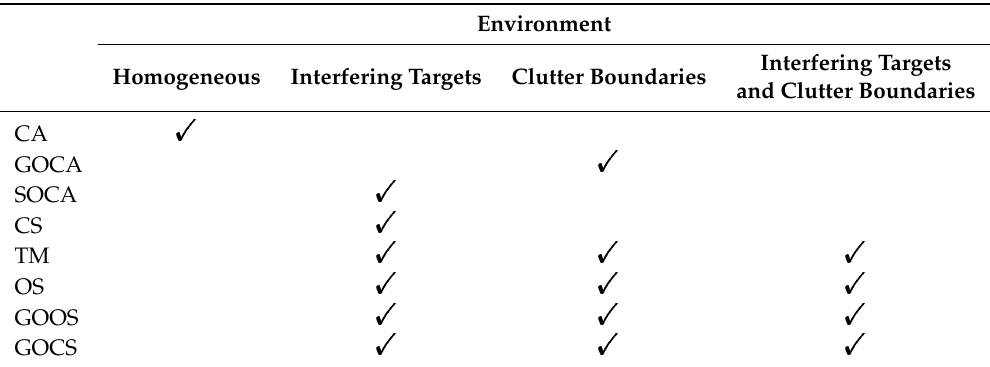
Table 2. CFAR algorithms and their operating